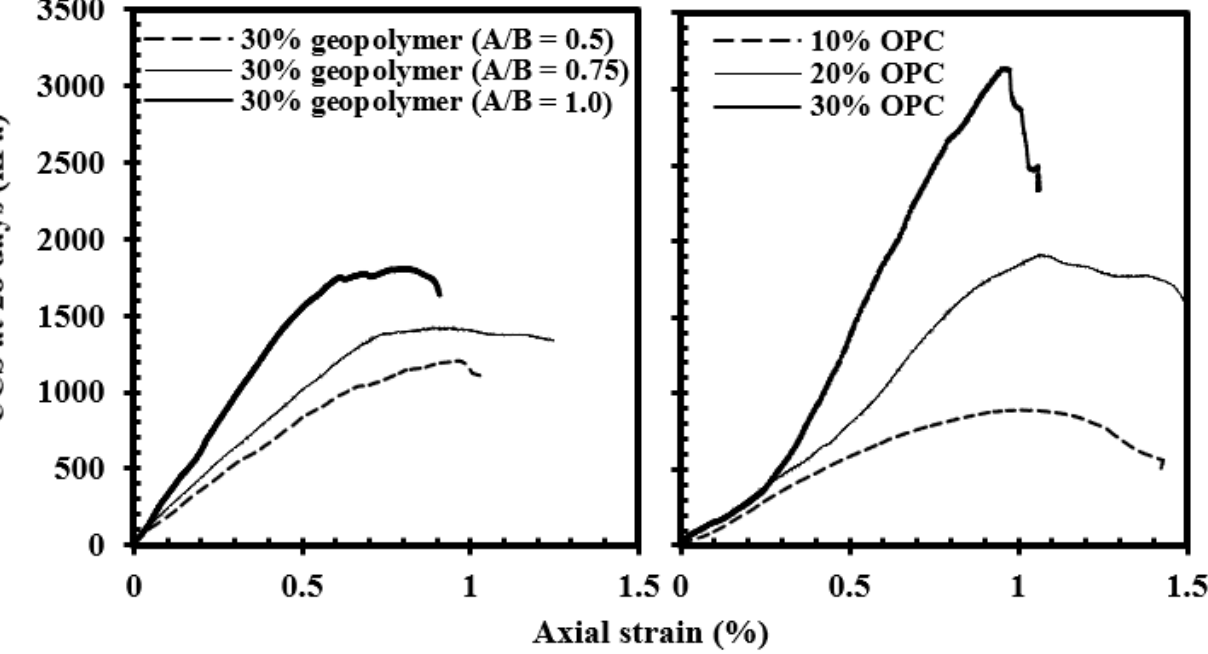
Figure 9. Typical stress–strain curves of geopolymer-stabilised clay and OPC-treated clay.